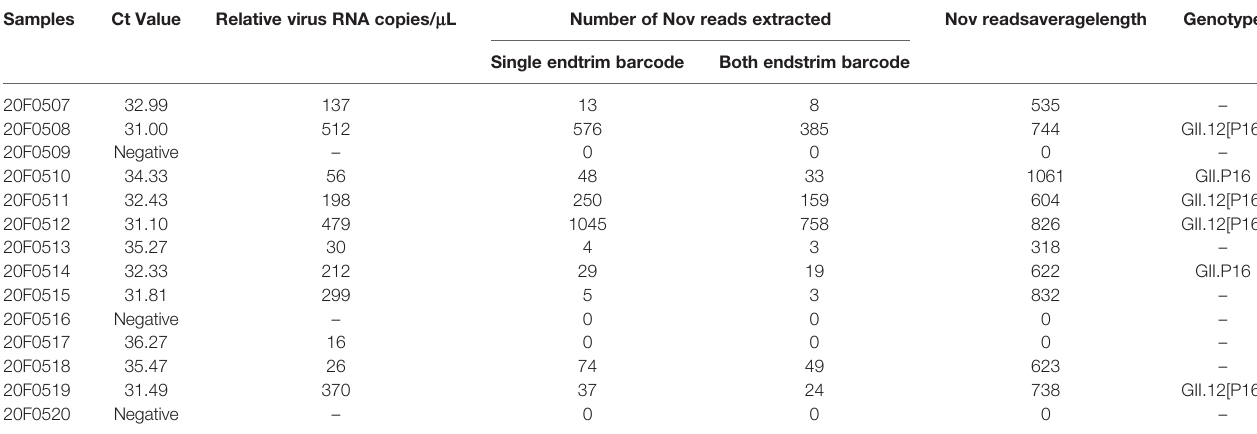
TABLE 1 | Ct values, Nanopore sequencing Nov reads extracted and genotype classi fi ed results for outbreak, May 10-June 13, 2020, Guangdong, China. Samples Ct Value Relative virus RNA copies/ m